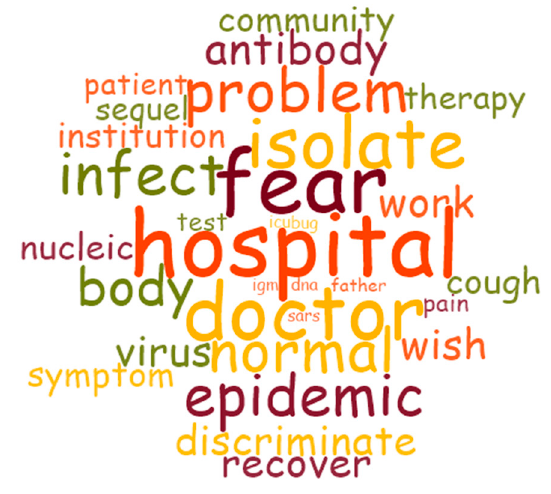
Figure 1. High Frequency Word Cloud.